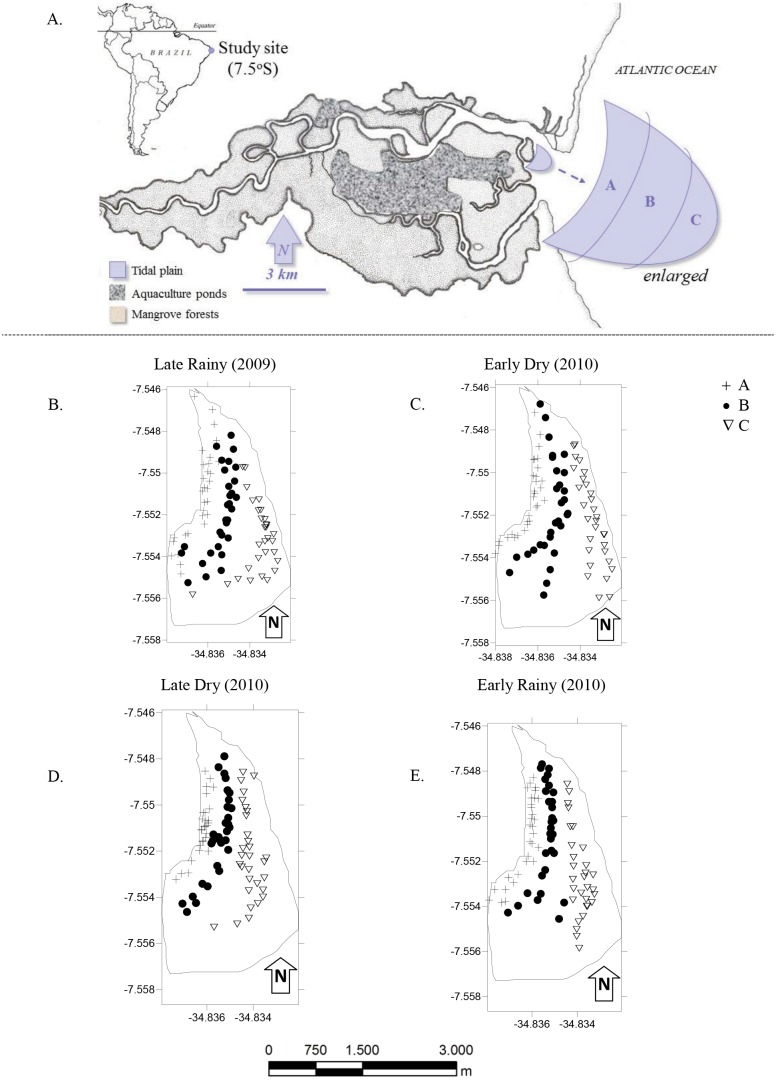
Study area.(A) Location of the Goiana estuary and position of the tidal plain within the estuary. (B–E) Distribution of cores (N = 360) according to season ((B) Late Rainy; (C) Early Dry; (D) Late Dry and (E) Early Rainy) and habitats (habitats A, B and C).